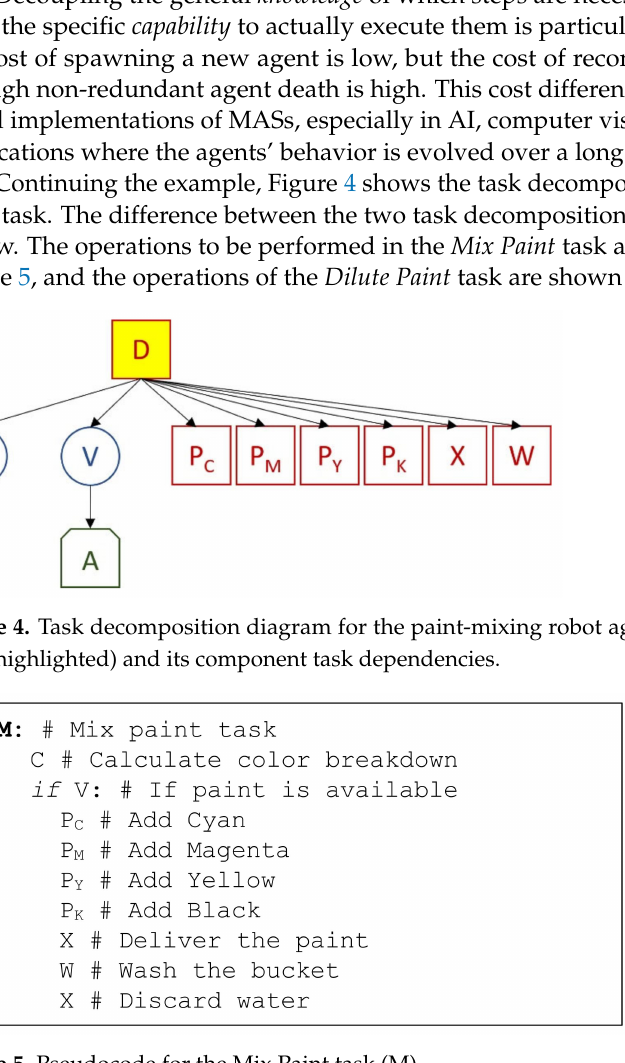
Figure 5. Pseudocode for the Mix Paint task